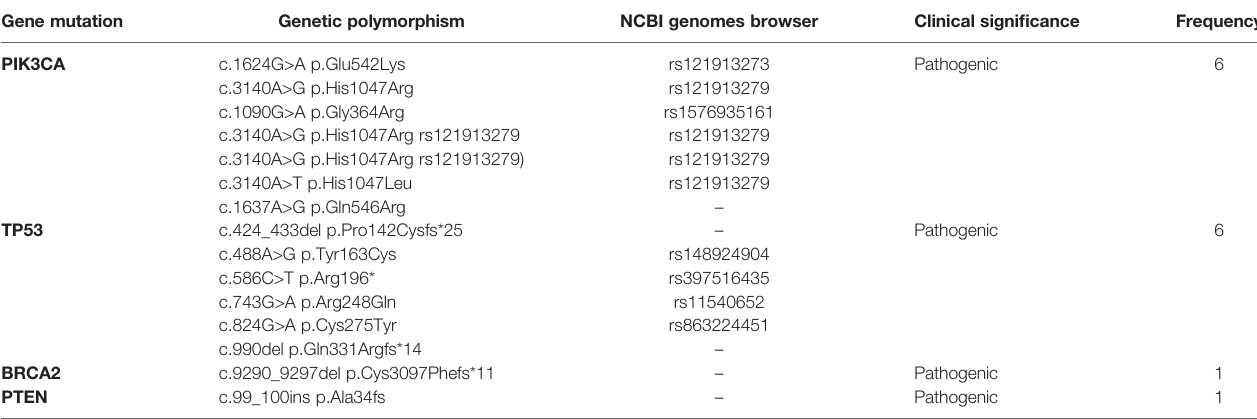
TABLE 7 | Somatic pathogenic mutations of young patients with breast cancer as determined by NGS analysis.